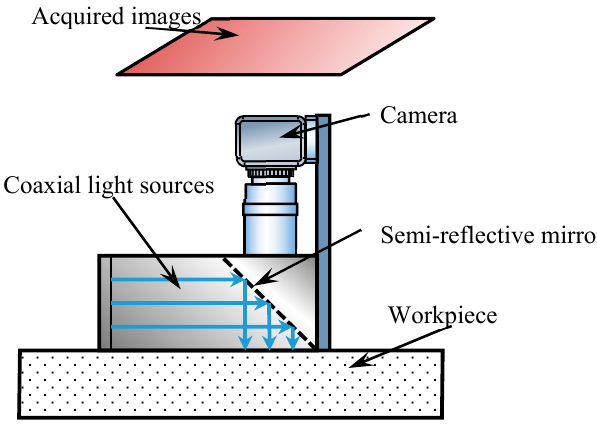
Figure 12. Structure sketch of the image acquisition system.